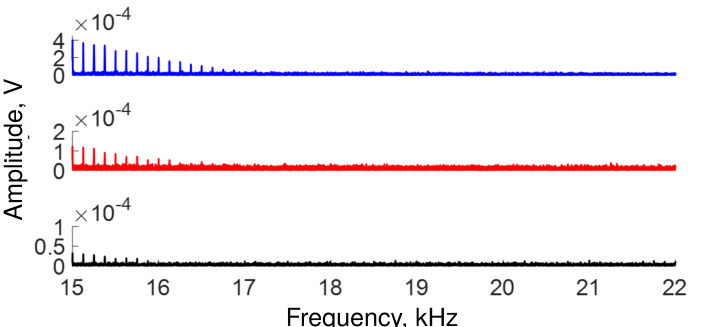
Figure 7. The OFSI response decays gradually at high frequencies. Specifically, the signal disappears at ∼ 17, ∼ 16.5, and ∼ 16 kHz, for blue, red, and black traces, respectively. In a second experiment, we play a sweep of frequencies from 0 to 22 kHz over 30